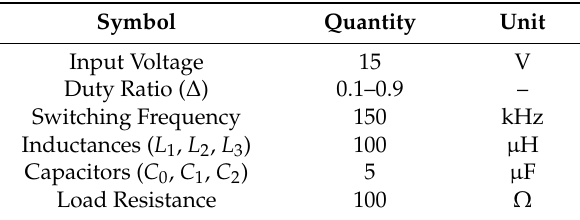
Table 1. Design parameters of Modified ´Cuk